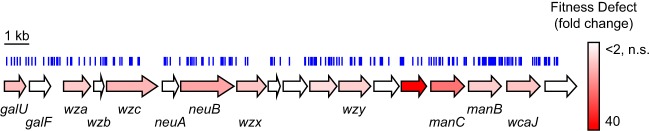
Involvement of the S. marcescens capsule biosynthesis locus in bacterial fitness. The ORFs of 18 genes within the putative capsule biosynthesis locus of strain UMH9 are depicted as arrows. Arrows without gene designations represent genes that encode hypothetical proteins. The level of fitness defect associated with each gene as determined by INSeq (ESSENTIALS) is indicated by red shading. Genes with a fitness defect of <2-fold or a fitness defect that was not statistically significant (n.s., adjusted P ≥ 0.05) are indicated by open arrows. The locations of 191 individual transposon insertions identified within this region are represented by blue vertical lines.